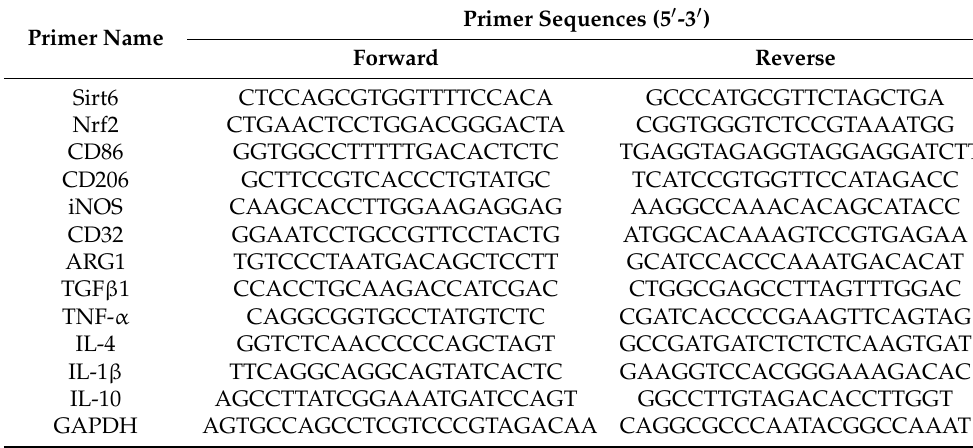
Table 2. Primers used in this